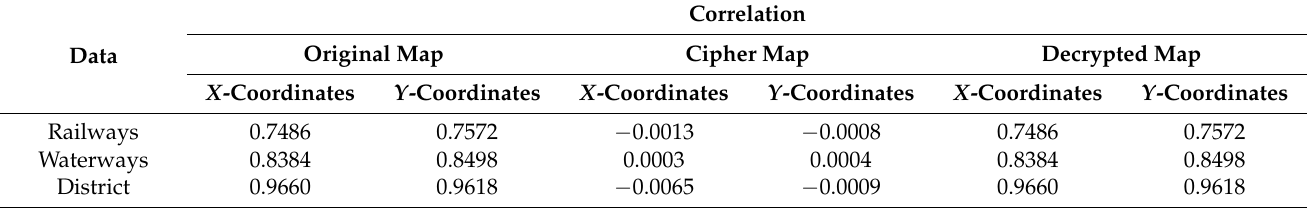
Table 1. Correlation of the original map, the cipher map, and the decrypted map.